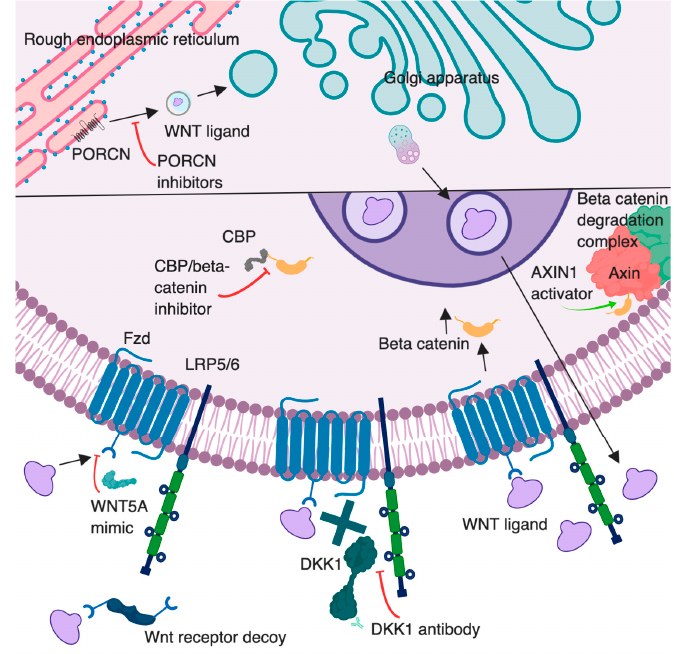
Figure 1. Overview of the canonical Wnt signaling pathway illustrating therapeutic intervention points targeted by Wnt modulators. The lower half of the figure represents a zoomed in portion of the cell. Porcupine (PORCN) inhibitors (e.g., LGK974) block secretion of WNTs by inhibiting their palmitoylation. AXIN1 activators (e.g., niclosamide) promote β -catenin degradation.